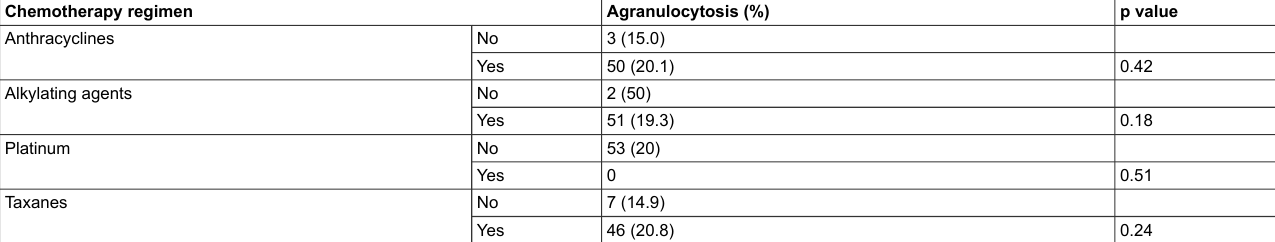
Table S2: Association between chemotherapy agent and mid-cycle neutrophil count. Chemotherapy